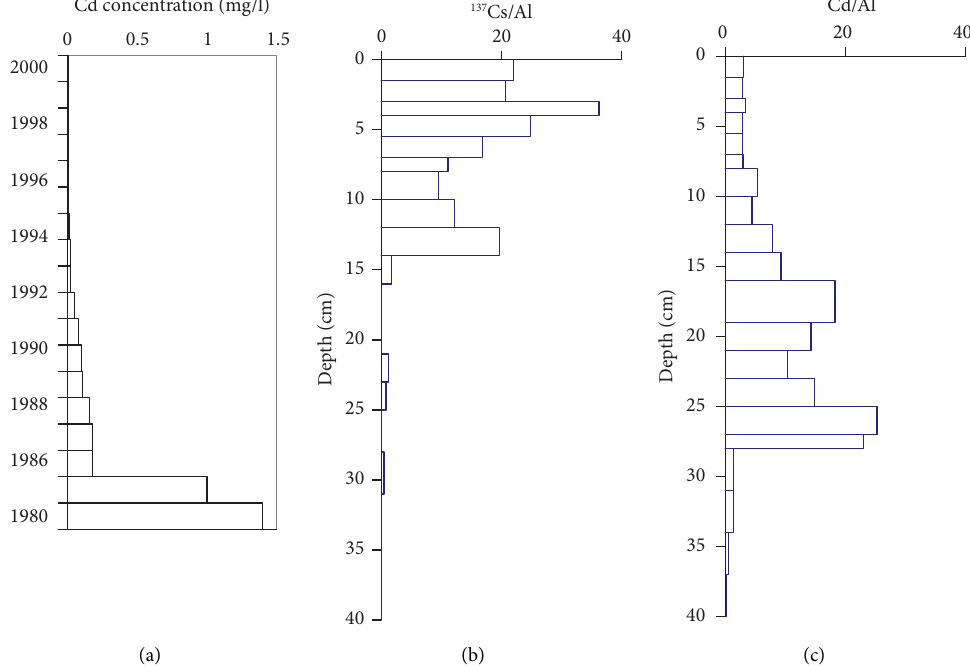
Figure 4: (a) Cd concentrations in the wastewater, (b) 137 Cs/Al ratio in core M , and (c) Cd/Al ratio s in core M , concentrations of Al and Cd in the soil samples were previously reported in reference [38]. Table 3: Cumulative release of Cd in the serial batch leaching tests with water and with a 0.085mol/l CaCl 2 solution. Average value of 3 replicates. Te pH of the solutions after extraction is also given. Data from reference [38].